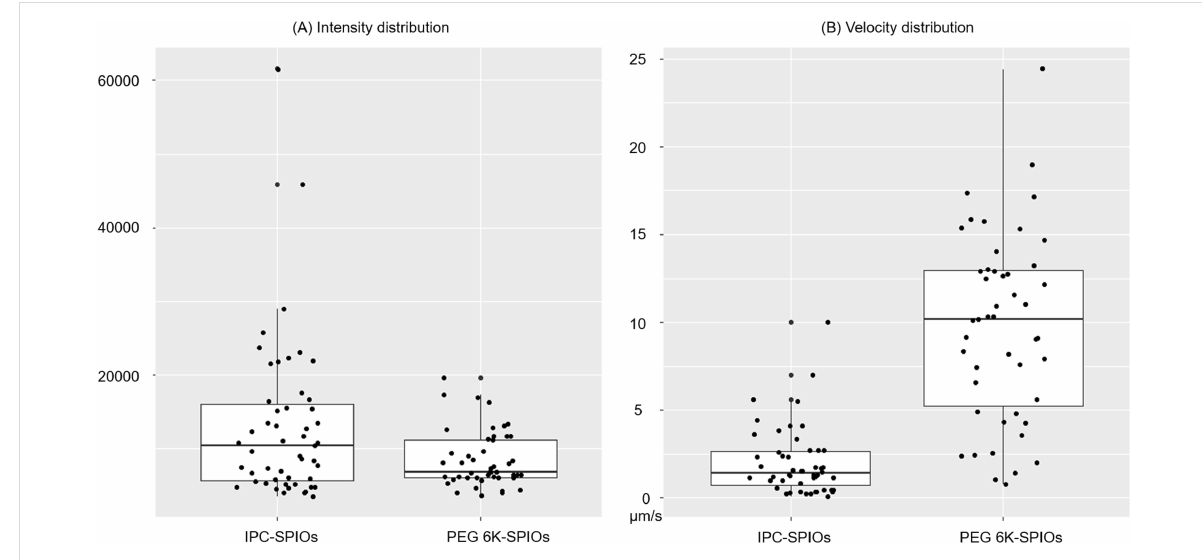
Figure 5: (A) Intensity and velocity distributions of PEG-SPIOs ( n = 47) and IPC-SPIOs n = 51), presented as box plots.